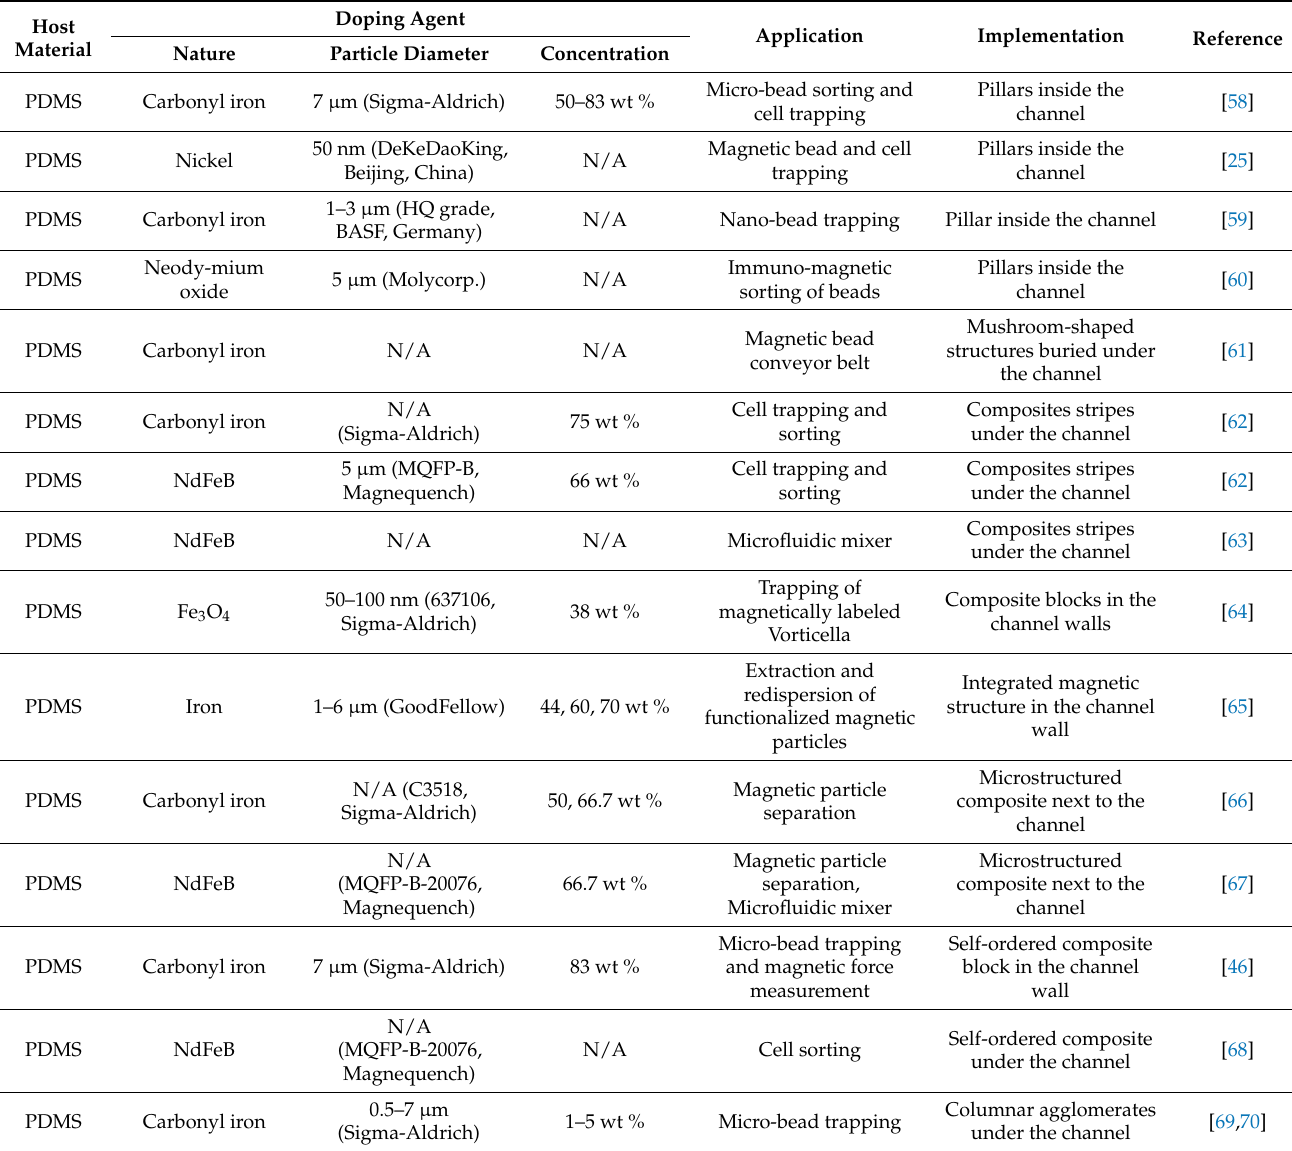
Table 1. Examples of magnetic composites in microfluidic devices for magnetophoretic applications. Host